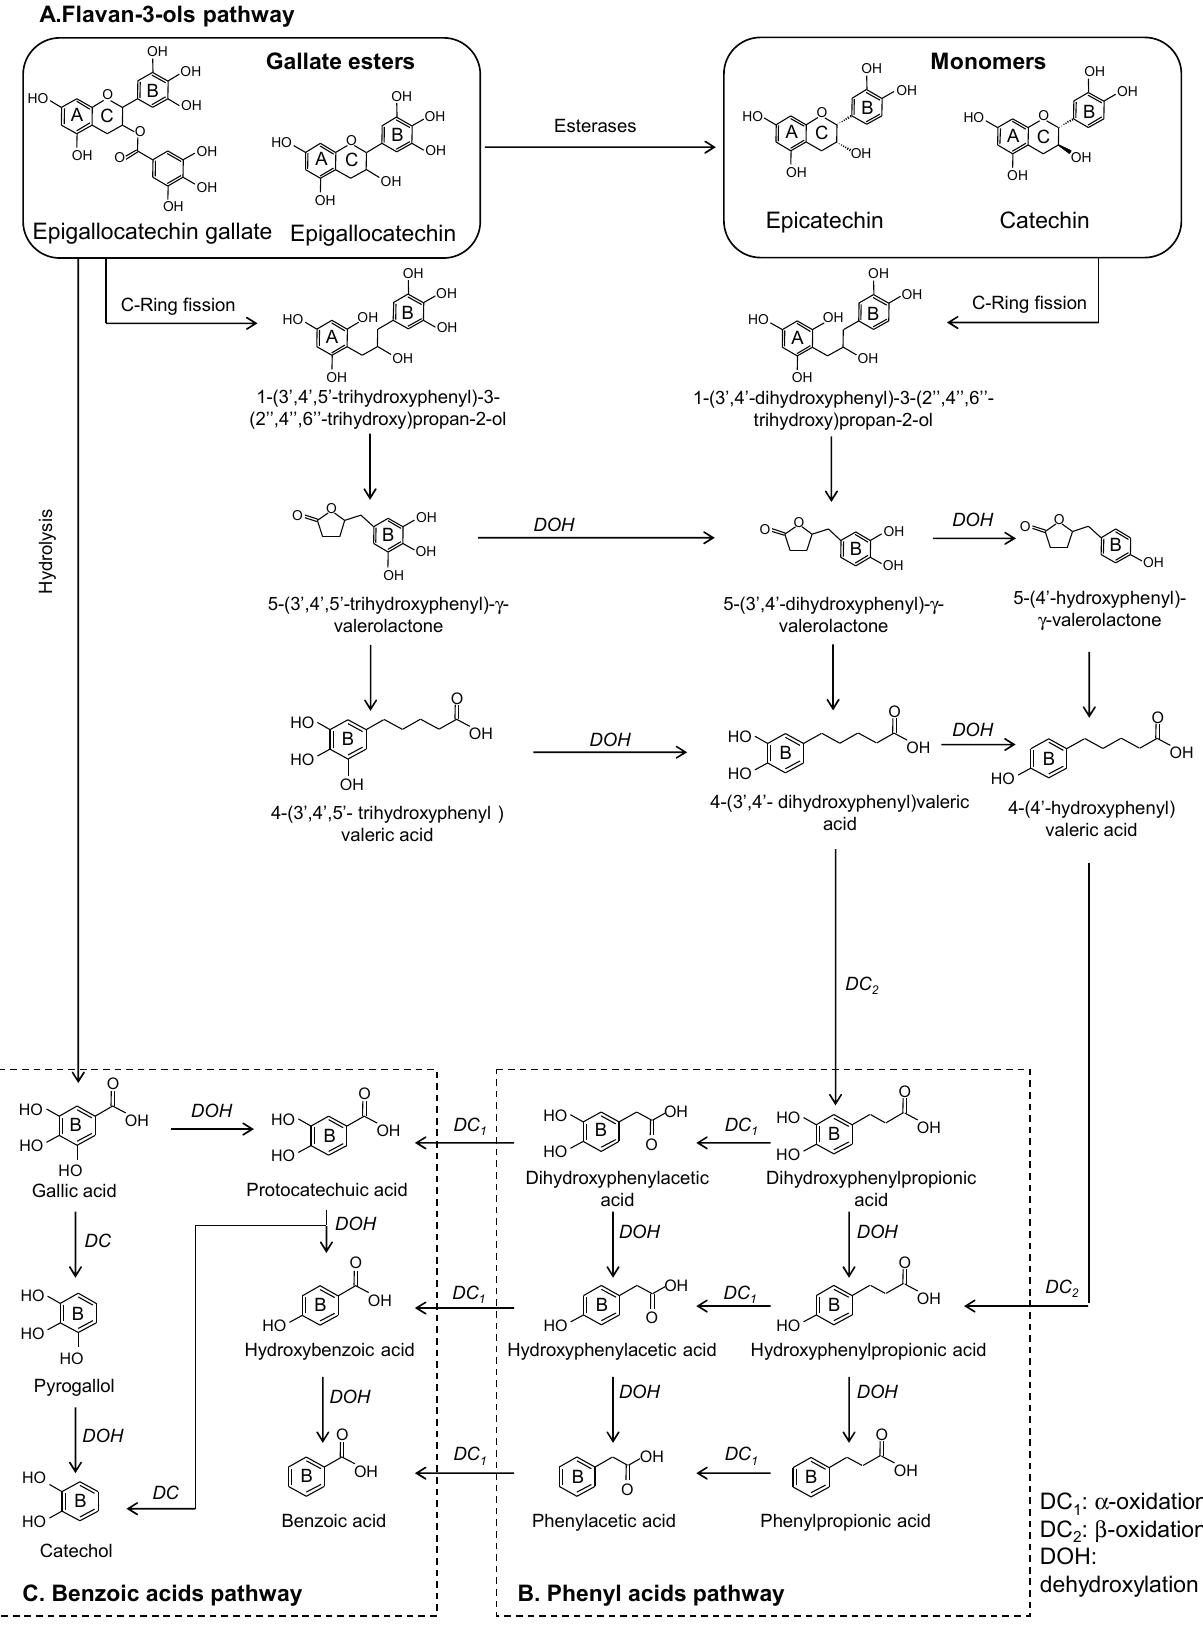
Figure 2. Proposed colonic pathways of monomeric flavan-3-ols and their corresponding gallate